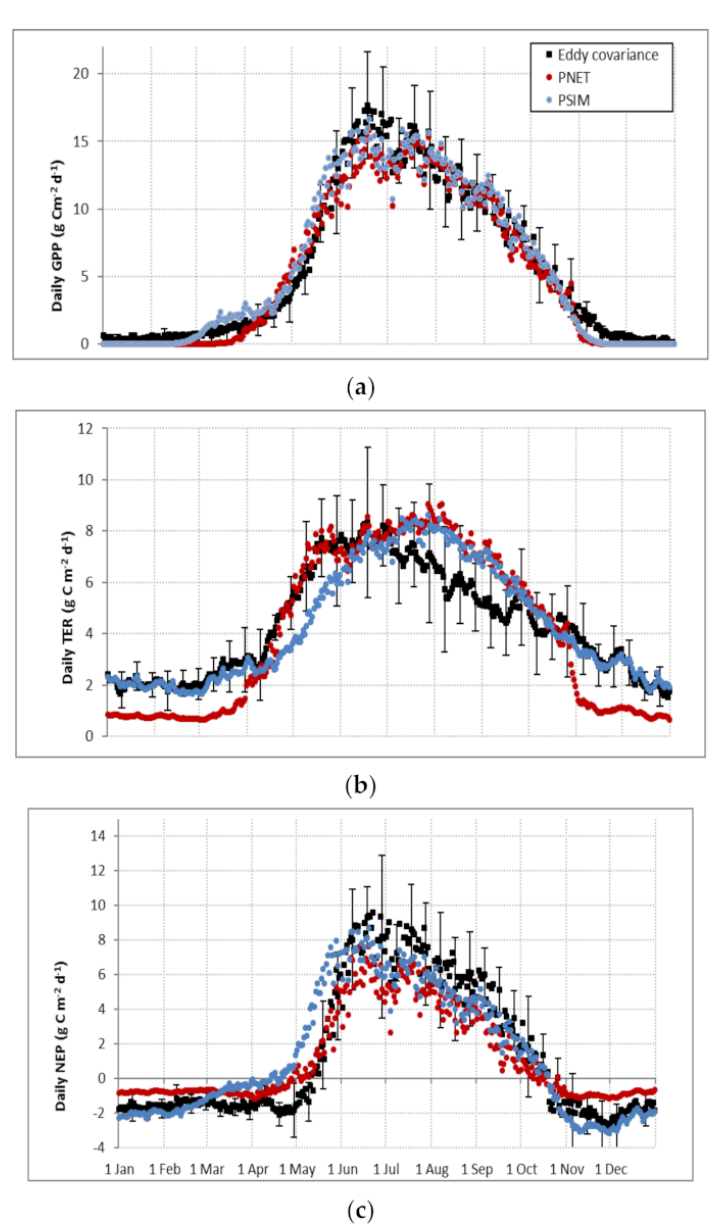
Figure 4. Average seasonal time course of ecosystem CO 2 flux components for the Straits Inclosure for 1999–2007: ( a ) GPP, ( b ) TER, ( c ) NEP. Each plot shows average daily values of measured eddy covariance fluxes with simulated PnET and PSIM data. Error bars shown on every tenth eddy covariance value are 1 standard deviation of annual